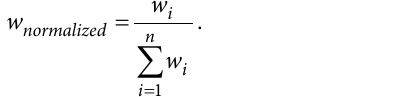
Table 3. The importance of criteria according to experts Criteria